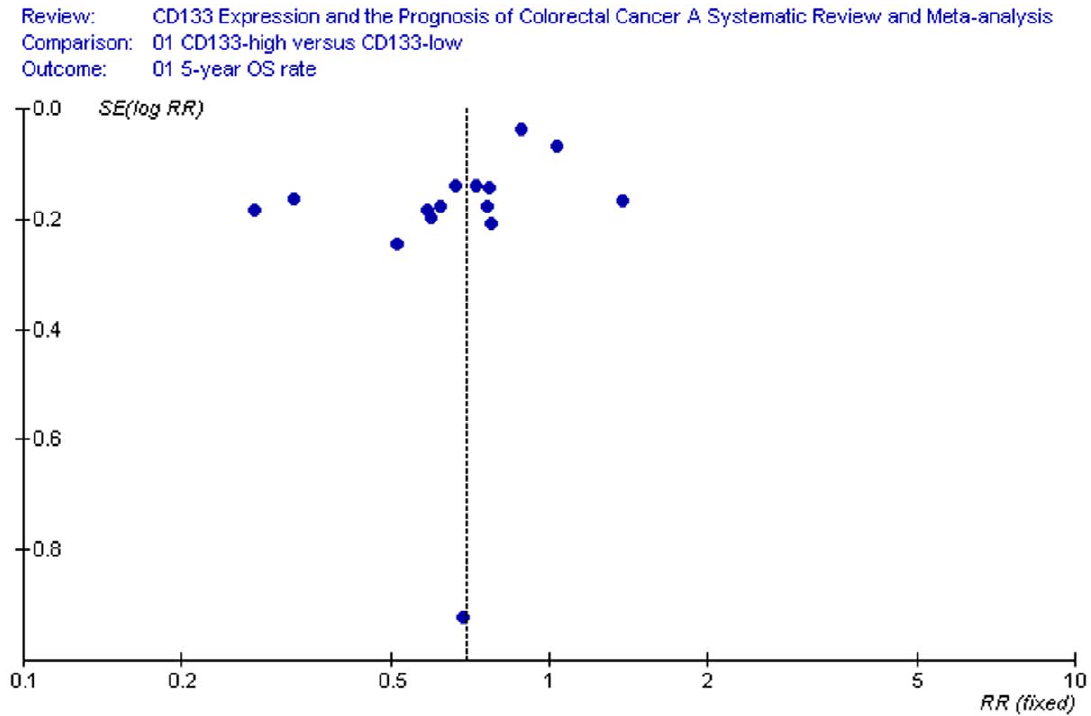
Figure 6. Funnel plot of studies used in the analysis of CRC 5-year OS rat